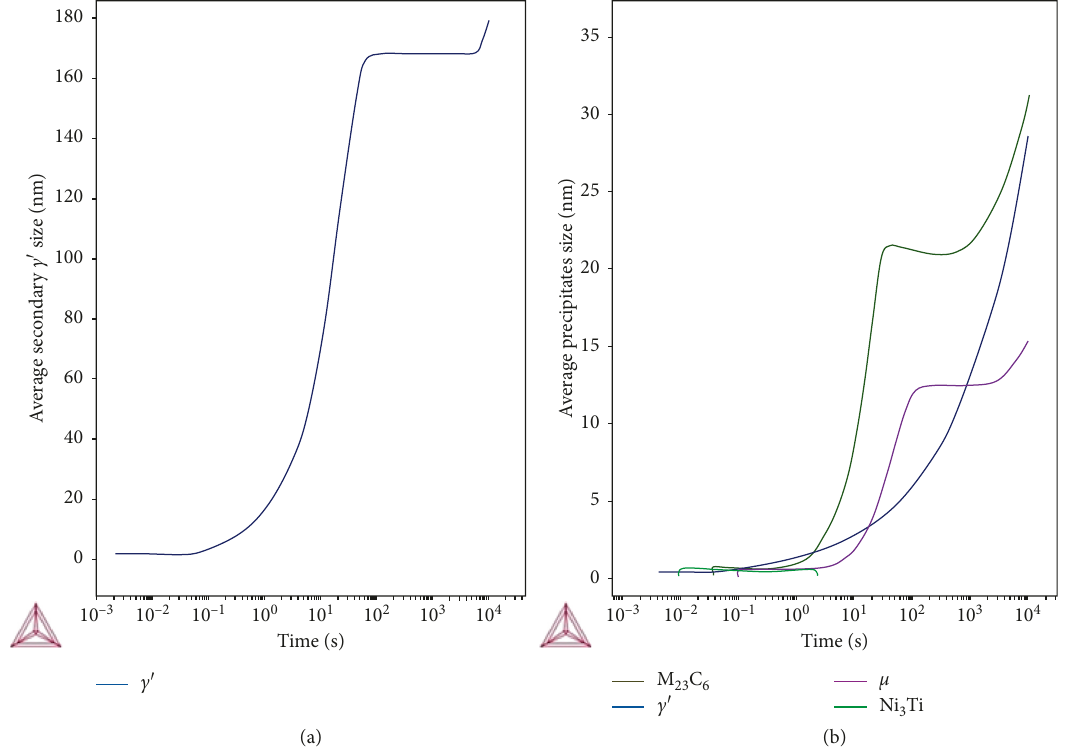
Figure 7: Mean radius of precipitates versus time for the conditions of heat treatment of (a) isothermal aging until 1353K (1080 ° C) and (b) double isothermal aging until 1118K (845 ° C).